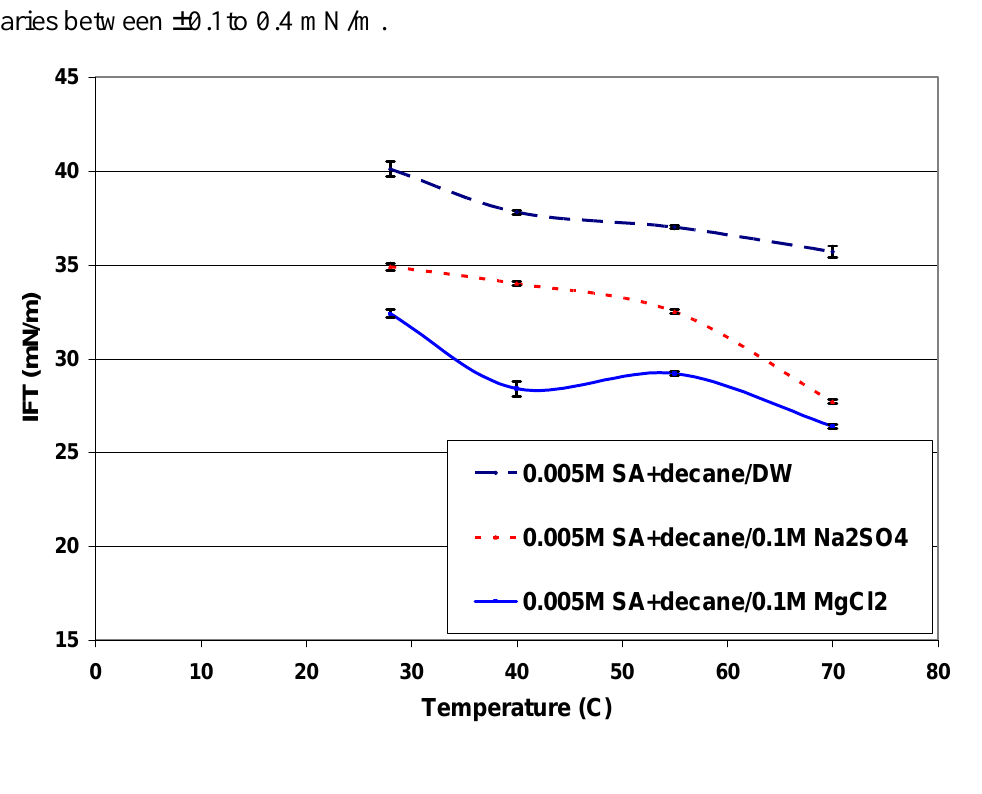
SO and 0.1M MgCl as a function of 2 4 2